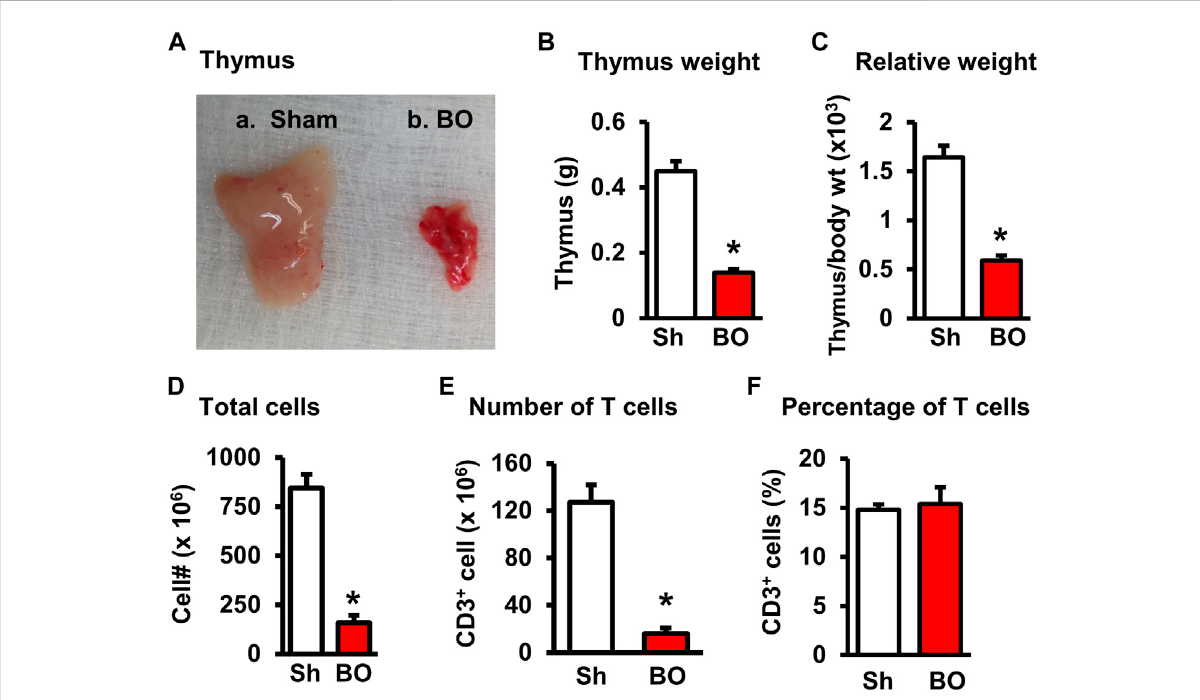
FIGURE 3 Effect of bowel obstruction on the thymus. (A) Isolated thymuses from a sham rat (A) and a rat with bowel obstruction for 7 days (B) . (B) Weight ofthymusinShandBOrats. (C) Ratioofthymusweight/bodyweight(x10 3 ). (D) Totallivelymphocytes. (E) NumberofTcells(CD3 + ). (F) Percentageof T cells (CD3 + ) among all lymphocytes. N = 9 per group for B and (C) N = 5 or 6 per group in D, E, and (F) * p < 0.05 vs. sham. Sh, sham. BO, bowel obstruction.